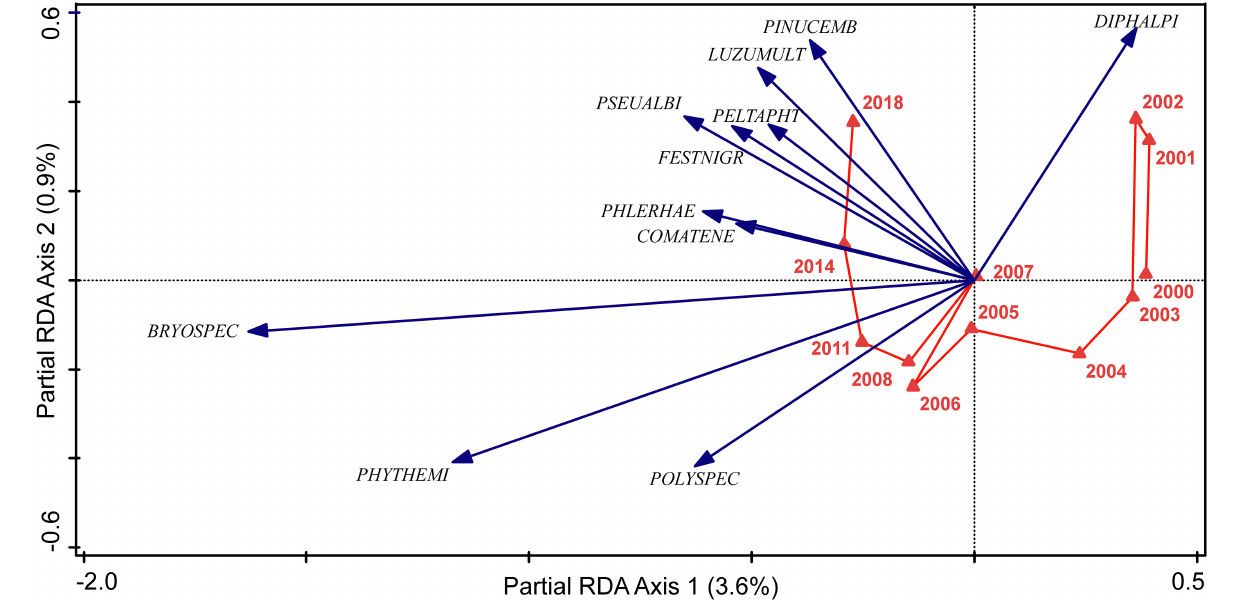
Geum montanum from the beginning; Anthoxanthum odoratum